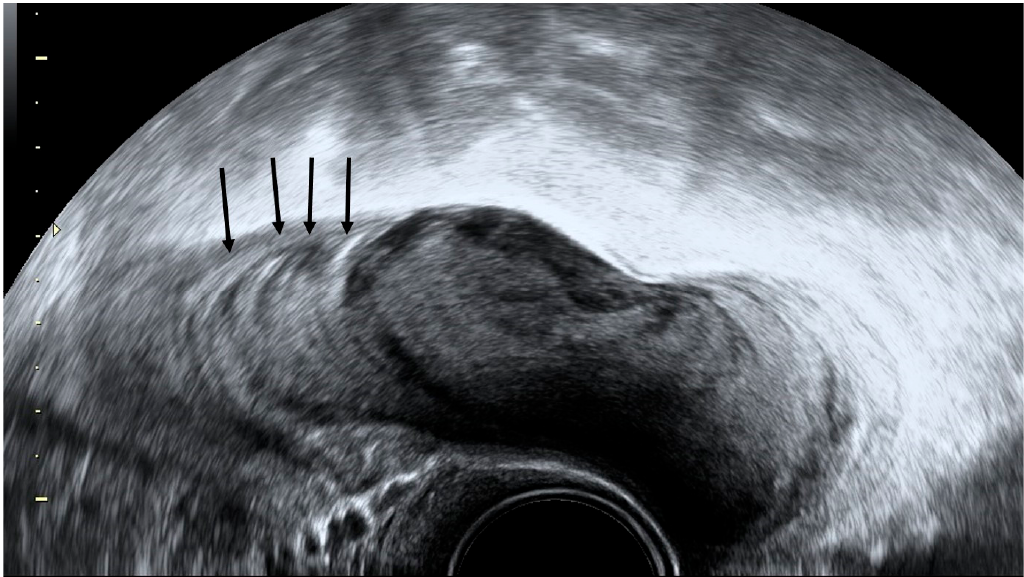
Figure 6. Sonographic features of an appendiceal mucocele. Ultrasound demonstrates the presence of characteristic concentric echogenic layers (arrows) within a cystic mass or “onion skin” pattern.